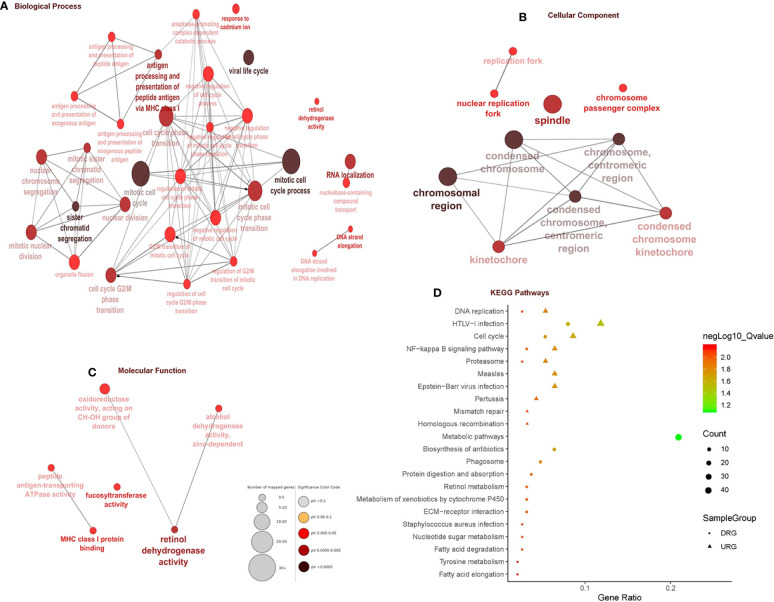
Gene ontology and pathway enrichment analysis. (A) Biological process analysis. (B) Cellular component analysis. (C) Molecular function analysis. (D) KEGG pathway analysis.